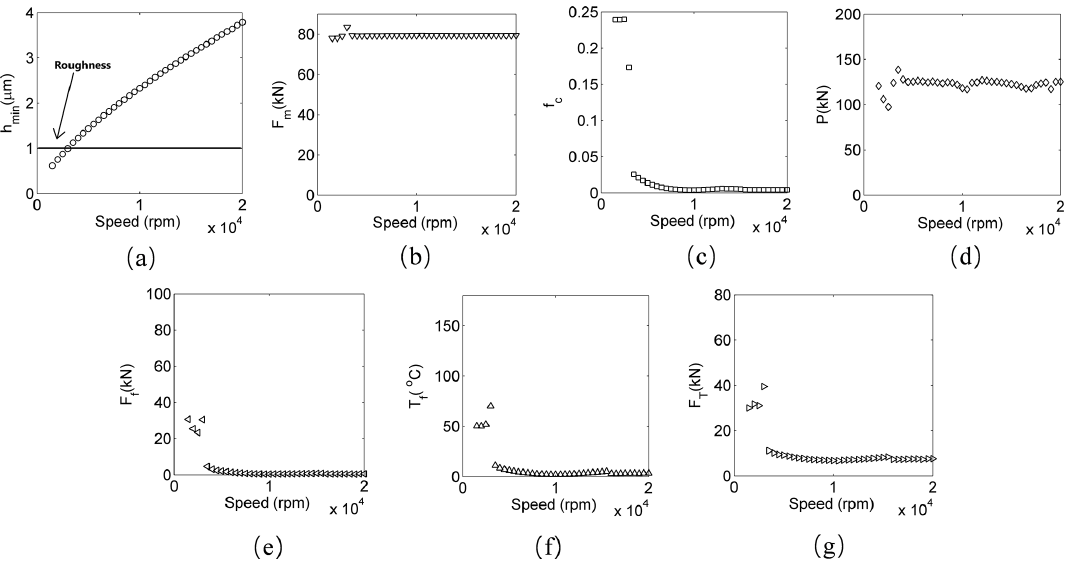
Figure 9. Response at the torque load of 5000Nm and the lubricating oil viscosity of 60cPs. (a) Minimum thickness of the lubricating oil; (b) meshing force; (c) friction coefficient; (d) pressure of the tooth surface; (e) friction force; (f) flash temperature; (g) thermal stress.